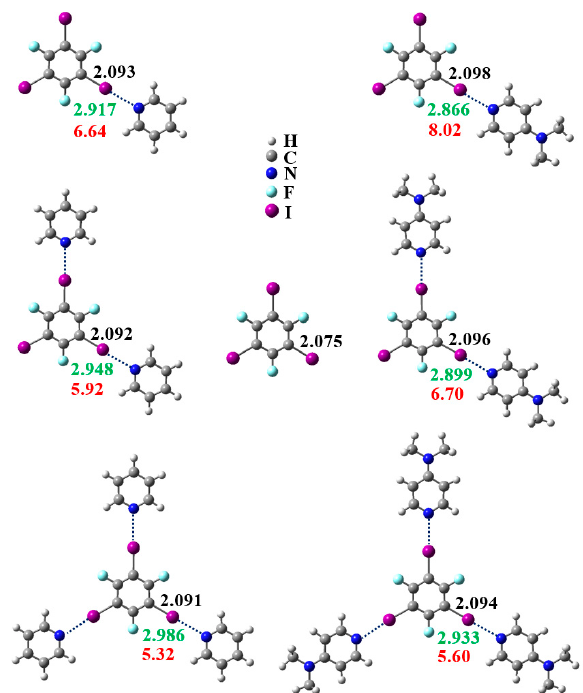
Figure 1. The C − I bond lengths (black numbers, in Å), I···N distances (green numbers, in Å), and C − I···N halogen bond strengths (red numbers, in kcal/mol) for the monomer 1,3,5-trifluoro-2,4,6- triiodobenzene (TFTIB) and molecular clusters containing TFTIB calculated at the ω B97X-D/def2- TZVPP level of